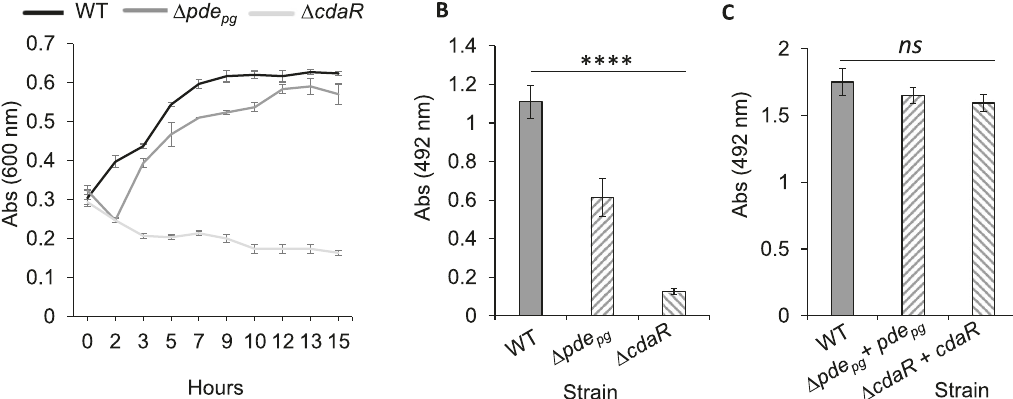
Fig. 3 Comparison of planktonic growth rate and bio fi lm formation. A Graph shows that Δ pde pg displays a lower rate of planktonic growth than the wild-type and Δ cdaR displays a signi fi cant growth defect. Cells were cultivated in the CDM-HSA-HK medium. B Bio fi lm assay using 96- well plates shows that both mutants produce less bio fi lms than WT in the CDM-HSA-HK medium. However, complementation of the mutants with relevant genes restored bio fi lm formation to the level of the wild type ( C ). Graphs represent mean biomass of bio fi lms ± SE (three biological replicates) at 48 h, as determined by safranin staining, which were analyzed using ANOVA test (Shapiro – Wilk test: P > 0.05). Asterisks indicate pairs of signi fi cantly different values (post hoc Tukey ’ s HSD test: **** P < 0.0001; ns not signi fi